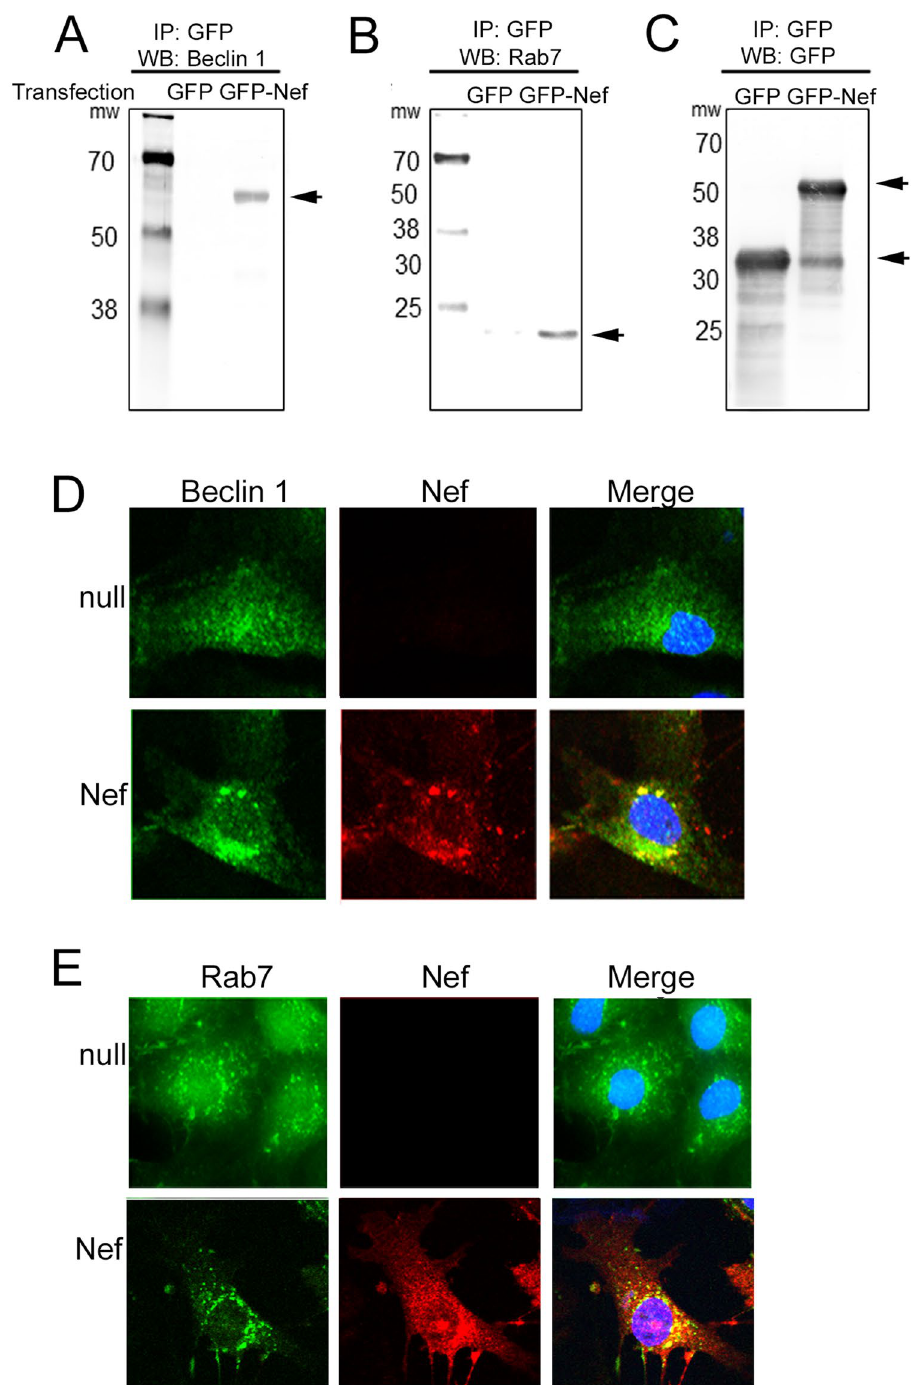
Figure 5. Nef binds to autophagy maturation factors Beclin 1 and Rab7 and colocalizes to the perinuclear space. ( A – C ) Nef interacts with the autophagy maturation factors Beclin 1 and Rab7, shown by immunoprecipitation. Nef-GFP fusion protein or GFP alone were expressed in the HEK293T cells for 3 days, lysates were immunoprecipitated using GFP-specific antibody, and immunoprecipitates were analyzed by Western blot with Beclin 1- (Panel A), Rab7- (Panel B), and GFP-specific (Panel C) antibodies. ( D , E ) Confocal images show that Nef colocalizes with Rab7 and Beclin 1 in perinuclear punctae. Cardiomyocytes were transduced with Ad-null or Ad-Nef for 48 hours, and cells were fixed and stained Beclin 1-, Rab7- and Nef- specific